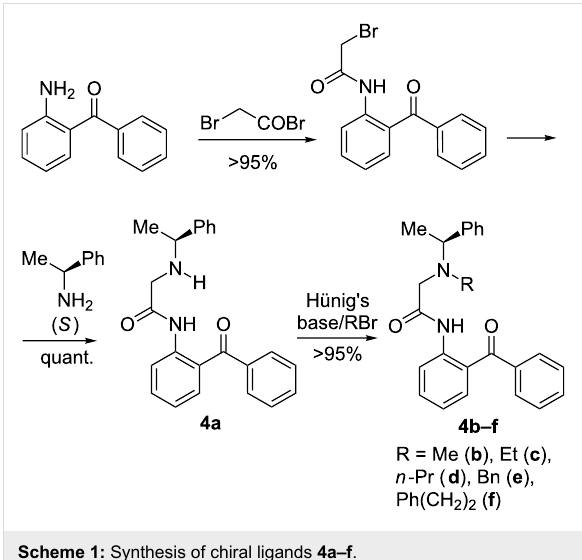
however, the chemistry of α -AAs continues to evolve